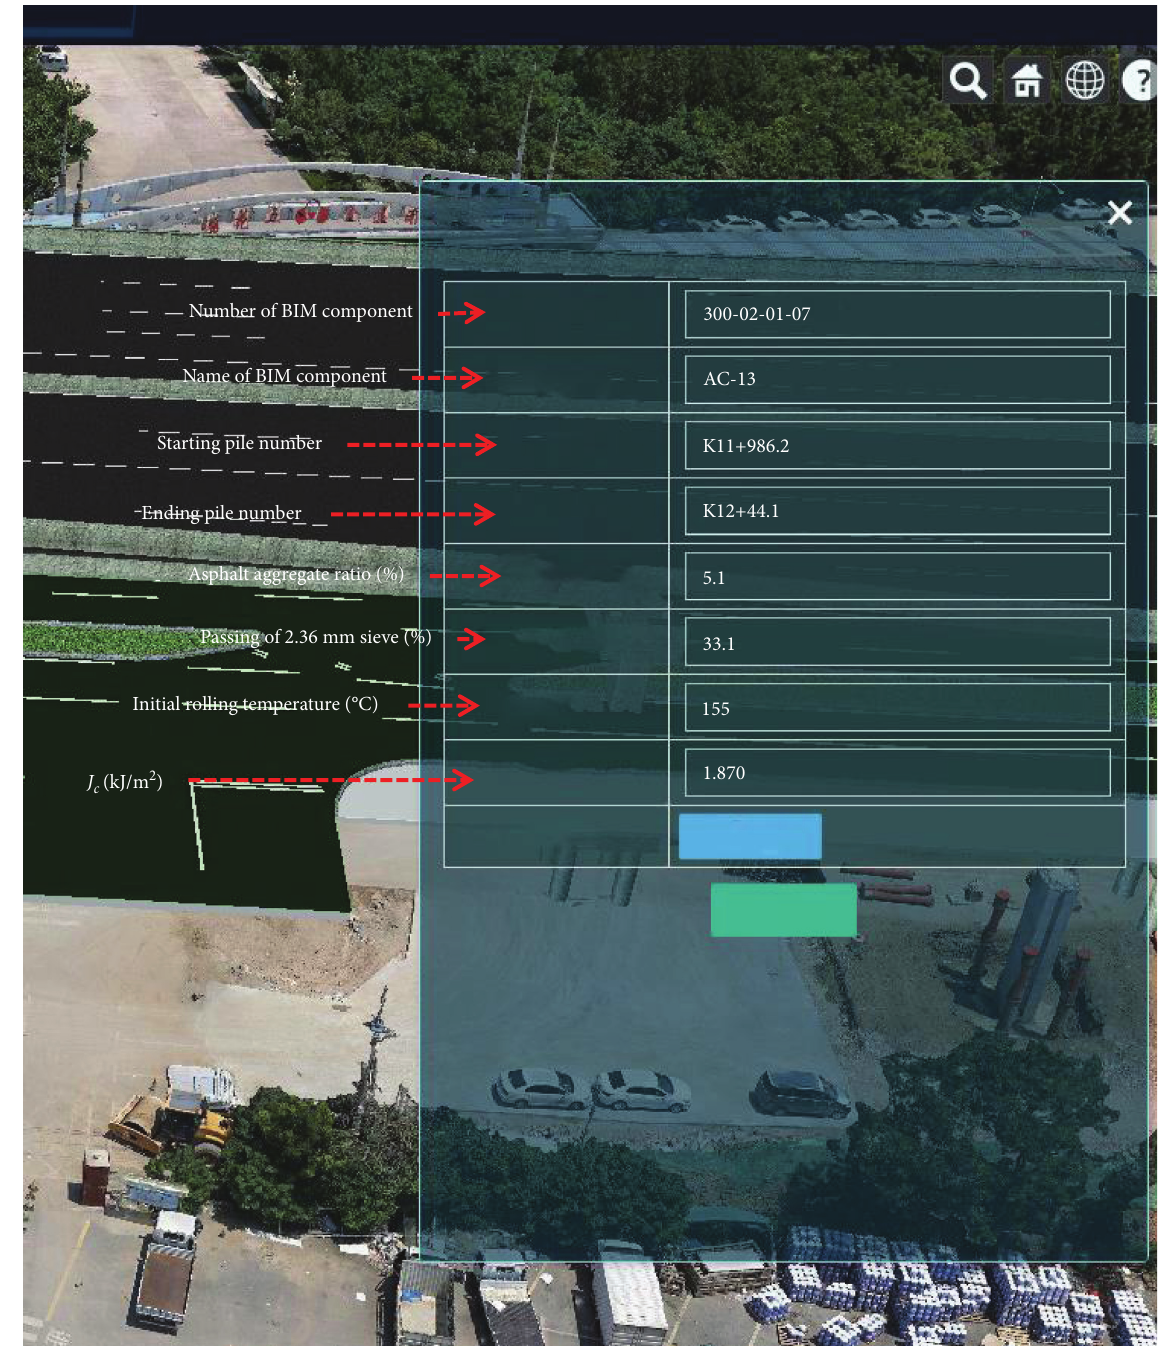
Figure 17: Display of construction information of a BIM component.